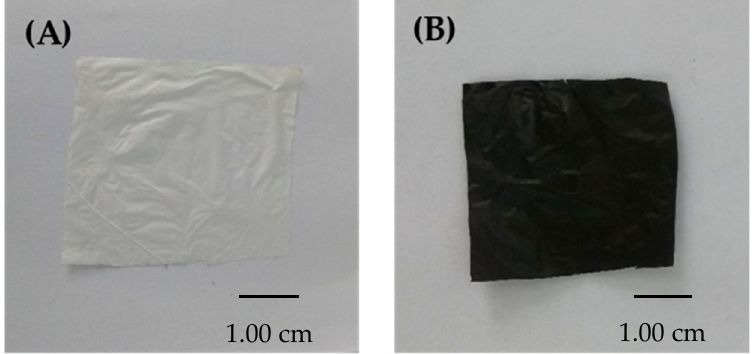
Figure 2. The picture of nylon 6 nanofibers membrane (PA6-NFsM) ( A ) and PPy / PA6-NFsM ( B ).